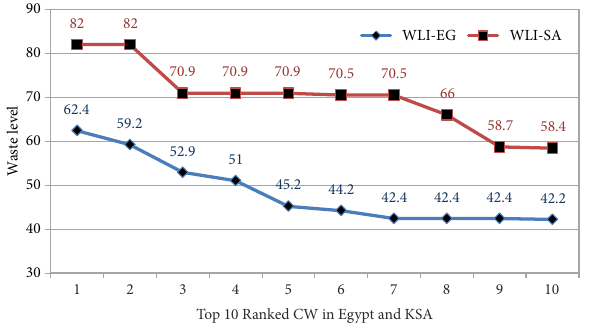
Figure 5. Waste level for top 10 ranked CWs